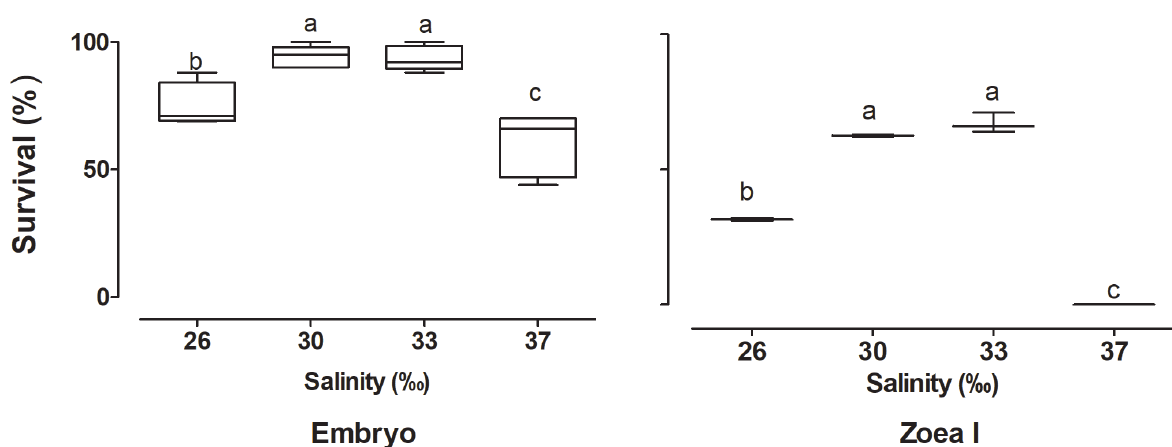
Figure 5. Ovalipes trimaculatus survival in embryos and zoeae I at different seawater salinity conditions. Different letters indicate significant statistical differences between mean survival (S) in Tuckey test. Central mark in box plots represents the mean value; upper and lower box extremes show the inter-quartile range of observed values; whiskers show maximum and minimum observed